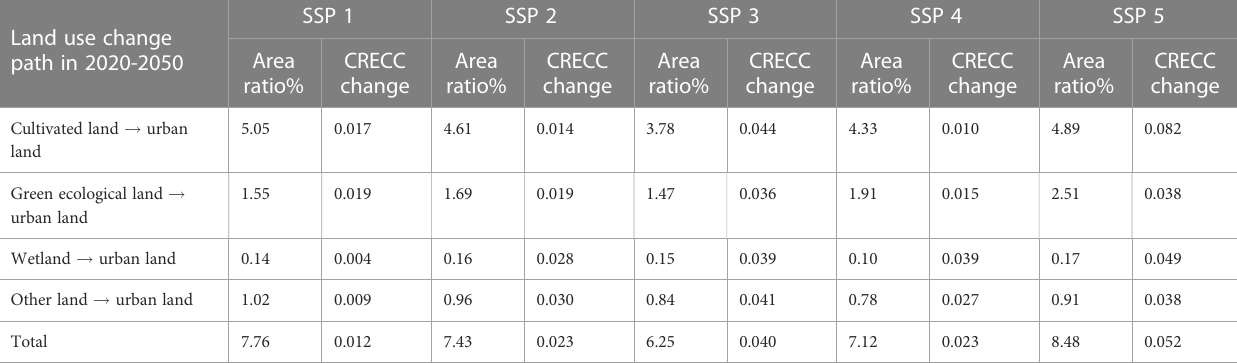
TABLE 8 Effects of major land-use changes on CRECC changes under different SSPs scenarios from 2020 to 2050.